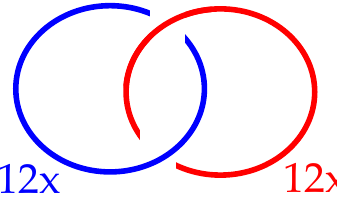
Figure 2 . The Hopf link. The discriminant locus of the TCS (cid:12)bration is a collection of 12 such Hopf links in the base of the (cid:12)bration, which are retract to the above image. To identify the speci(cid:12)c Calabi-Yau, (cid:12)rst note that the Euler characteristic of X given